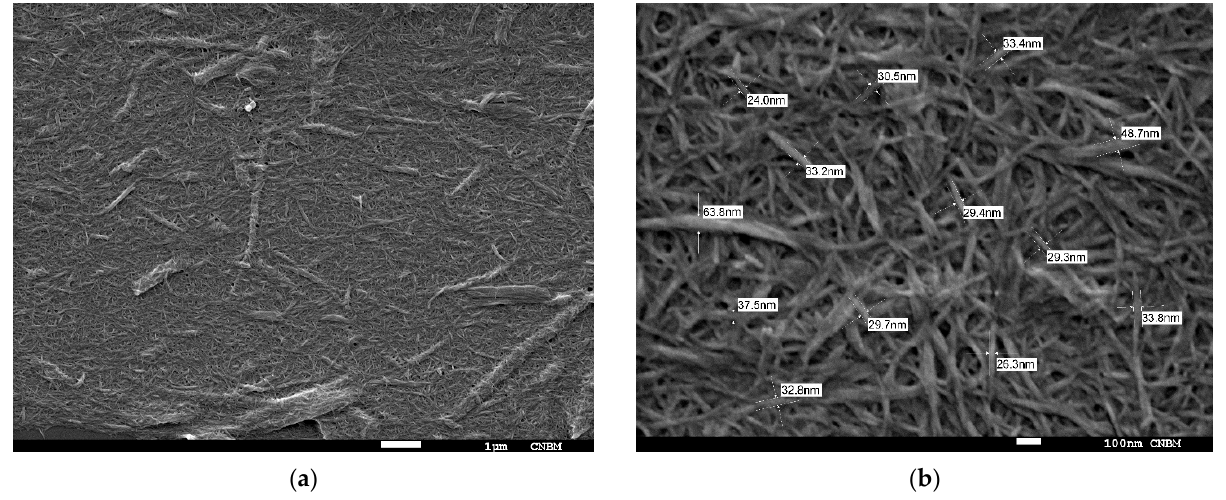
Figure 2. SEM image of CNF(W): ( a ) nanocellulose structure; ( b ) diameters of cellulose fibres.